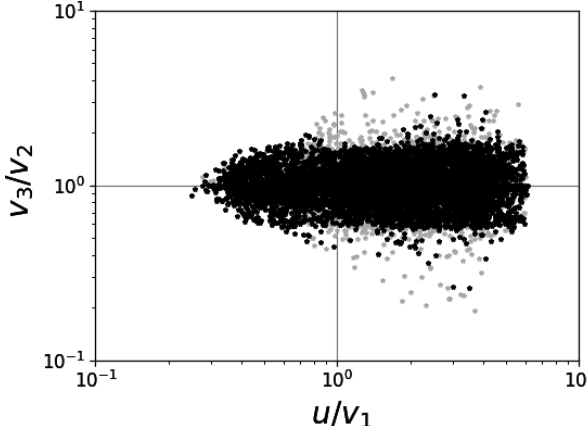
Figure 2 . Allowed region for the vev ratios v 3 =v 2 and u=v 1 .